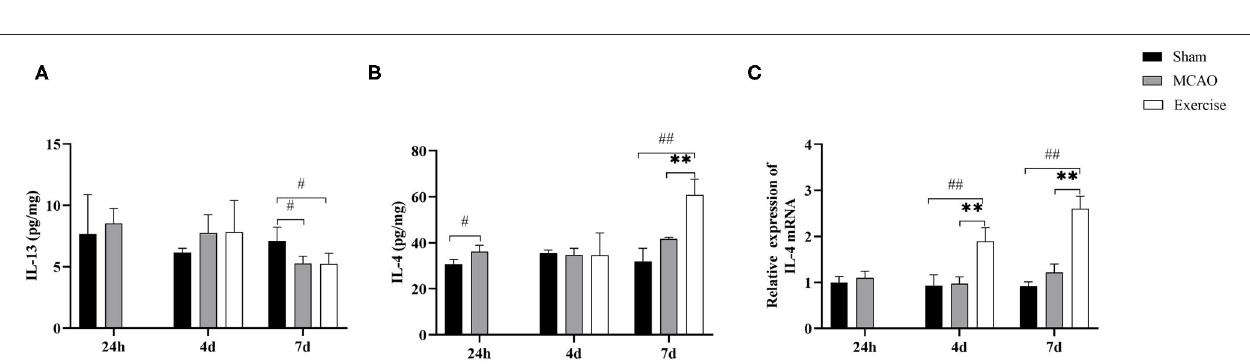
FIGURE 5 | Treadmill exercise increased the expression of IL-4 after MCAO. Protein concentrations of IL-13 (A) and IL-4 (B) in the penumbra were measured by Luminex Multiplex Assays on day 1, 4, and 7 post-surgery in the sham, MCAO and exercise groups. (C) RNA extracts were prepared from the penumbra and mRNA analysis of IL-4 was detected by real-time PCR at the same time points in the 3 groups. Data are given as the mean ± SD. n = 3/group. # P < 0.05, ## P < 0.01 vs. sham group; ** P < 0.01 vs. MCAO